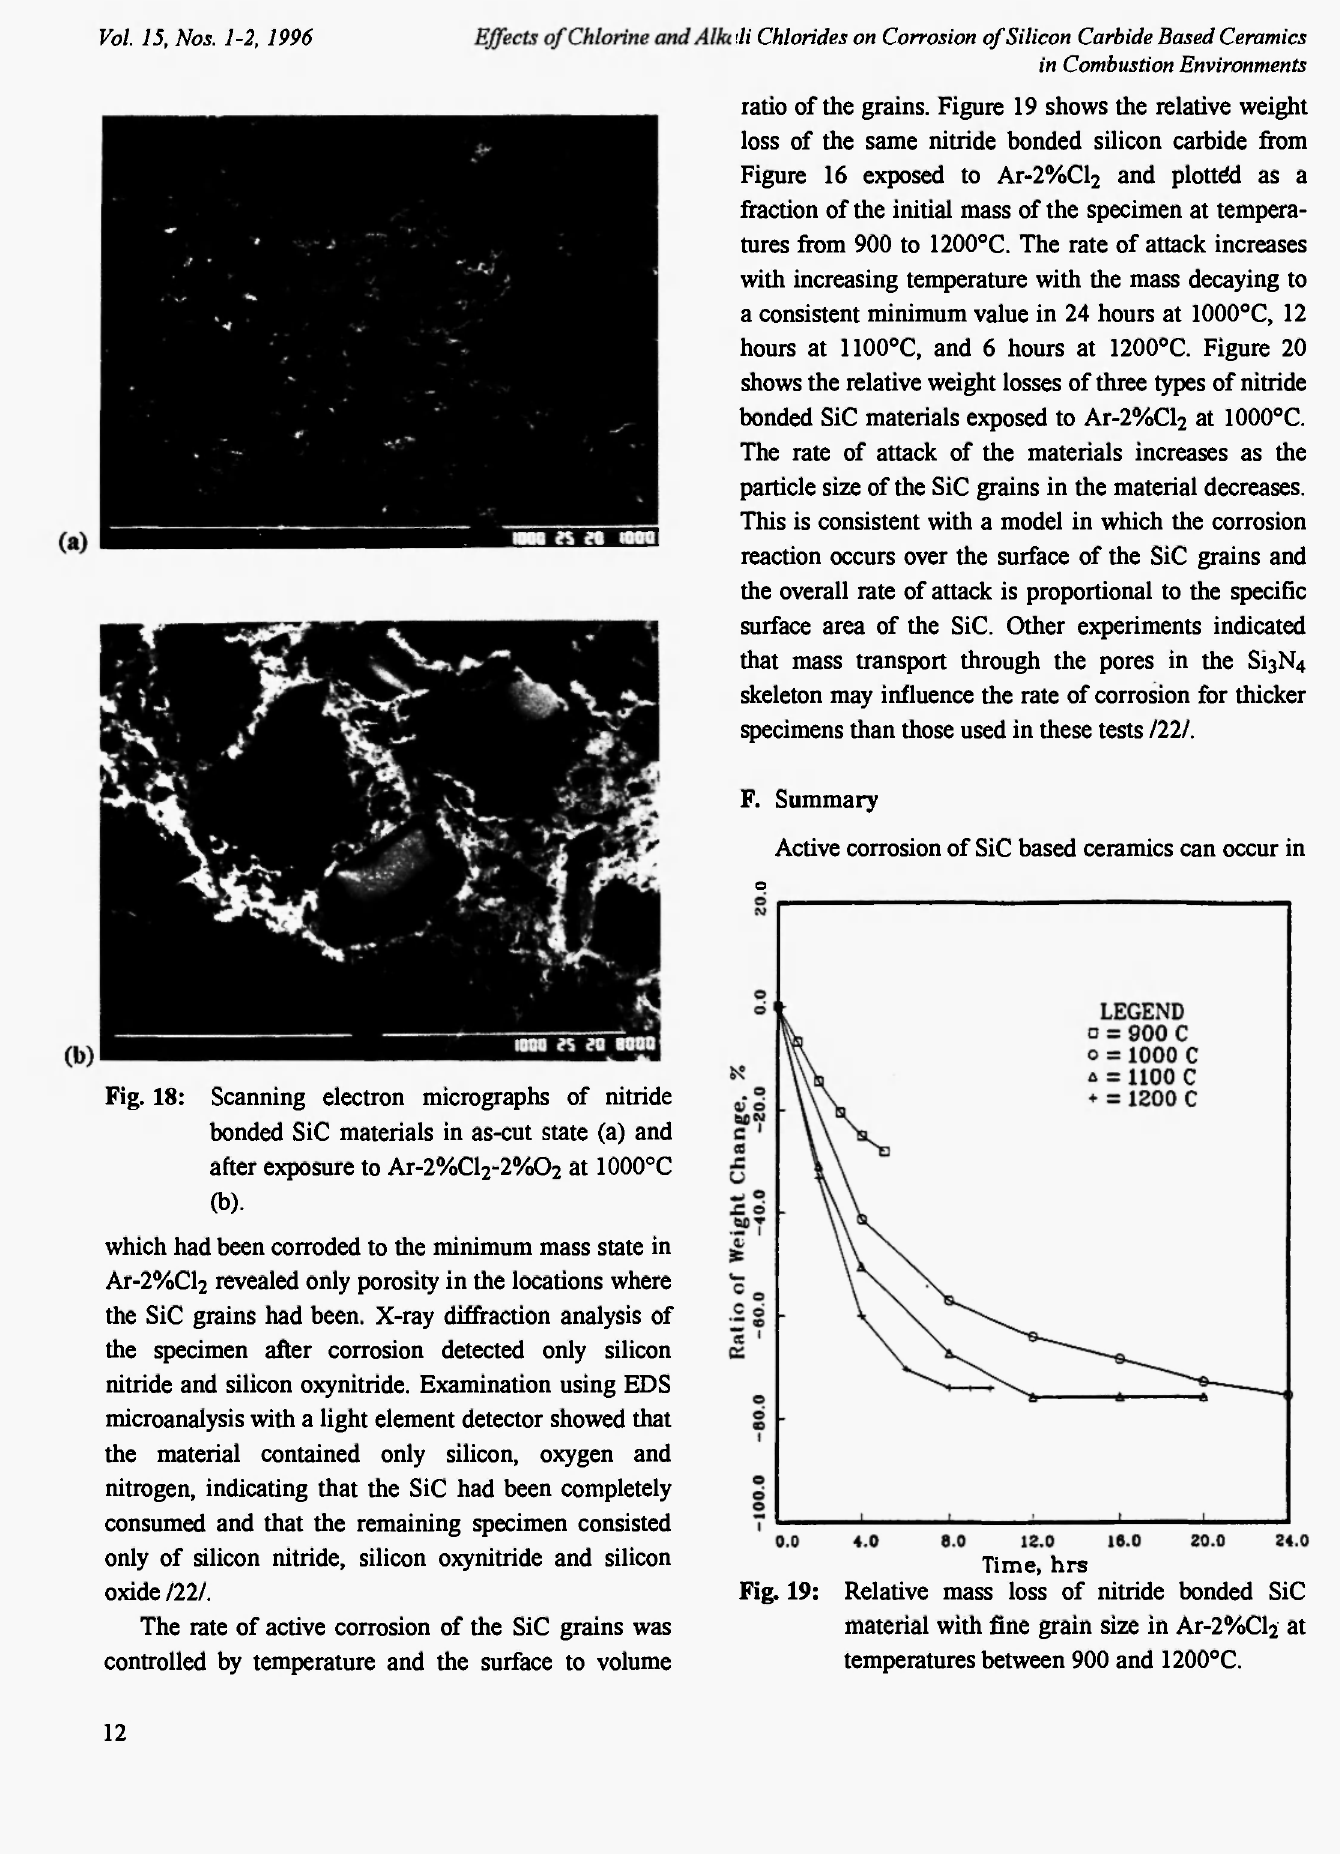
Fig. 19: Relative mass loss of nitride bonded SiC material with fine grain size in Ar-2%Cli at temperatures between 900 and